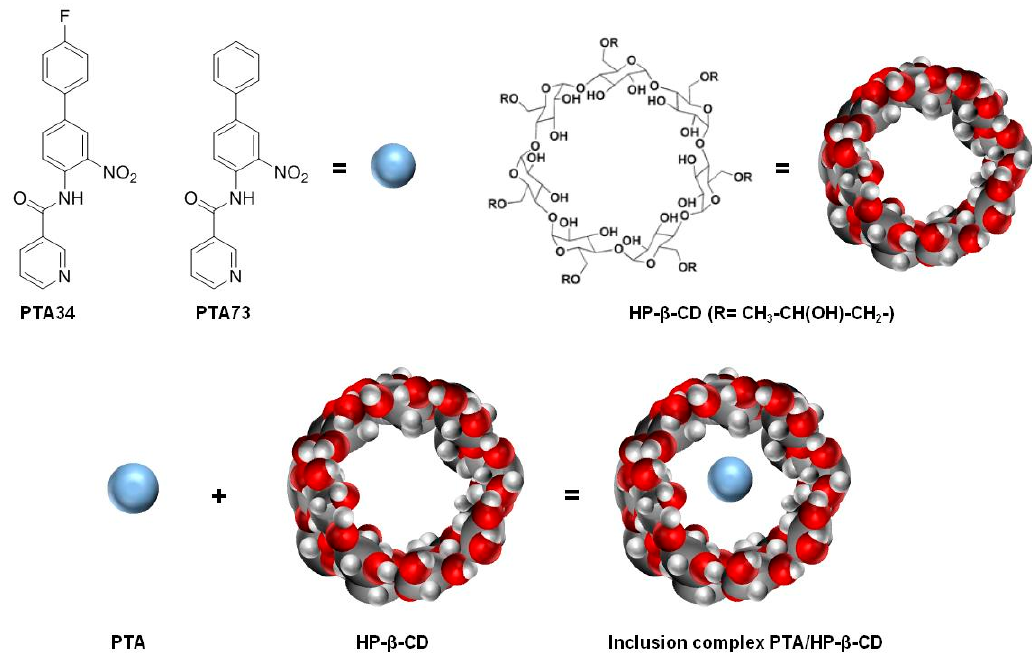
Figure 1. Chemical structures of PTA34, PTA73, hydroxy-propil- β -cyclodextrin (HP- β -CD) and graphical representation of the inclusion complex.